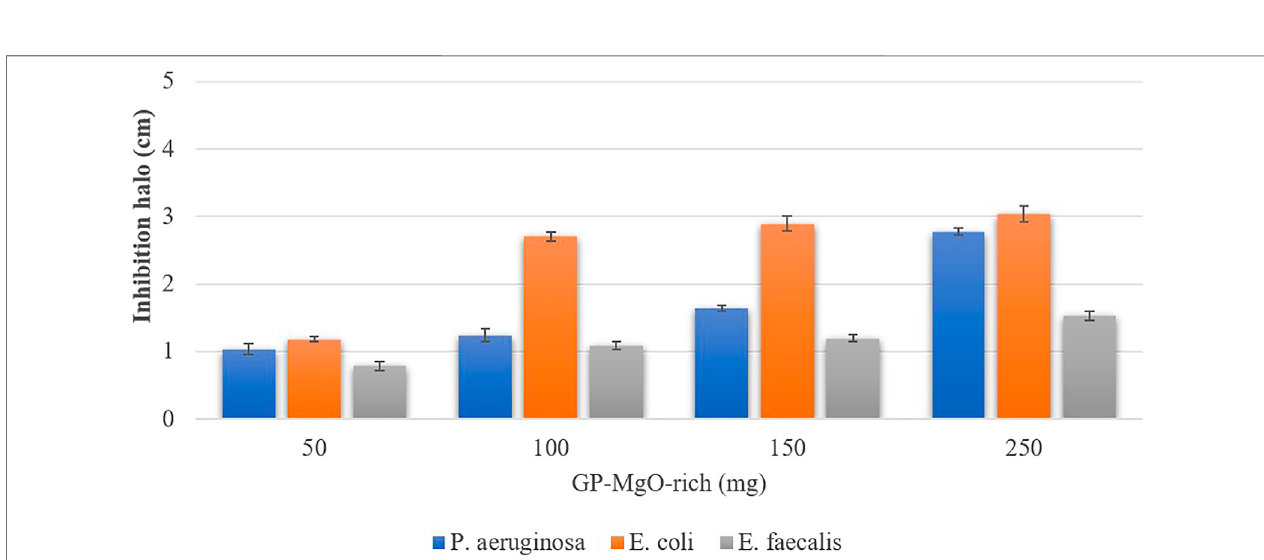
Frontiers in Materials |